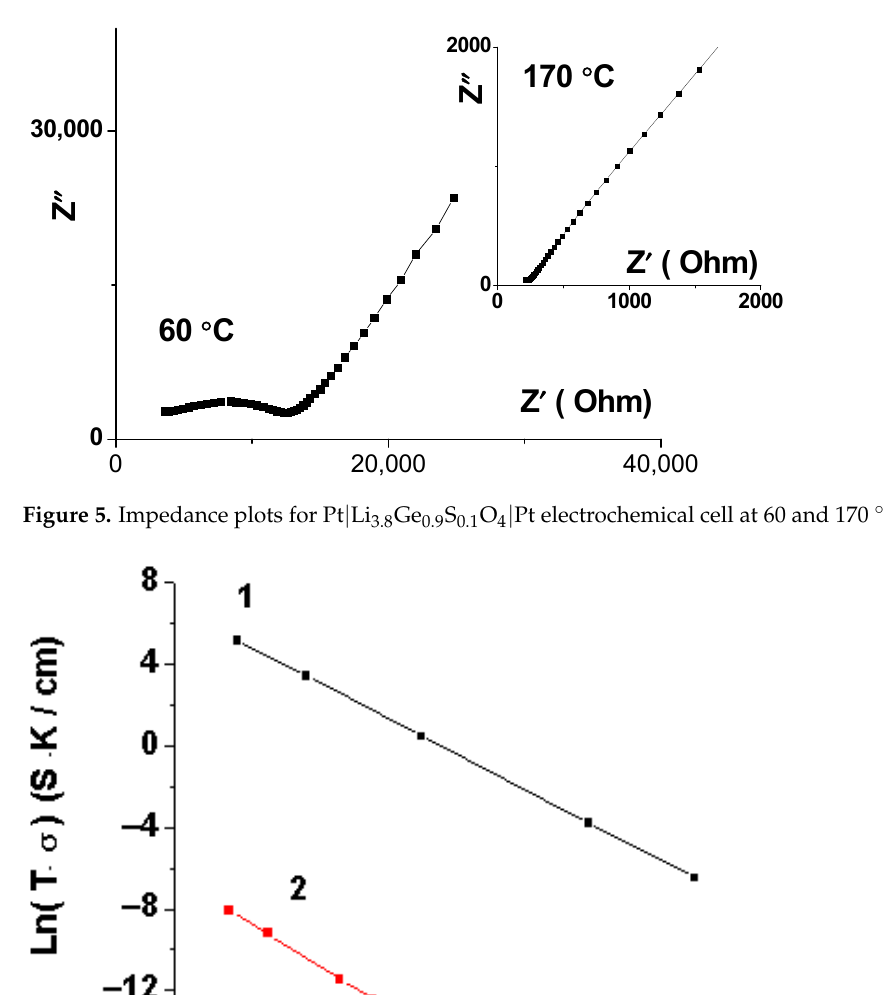
Batteries 2023 , 9 , x FOR PEER REVIEW